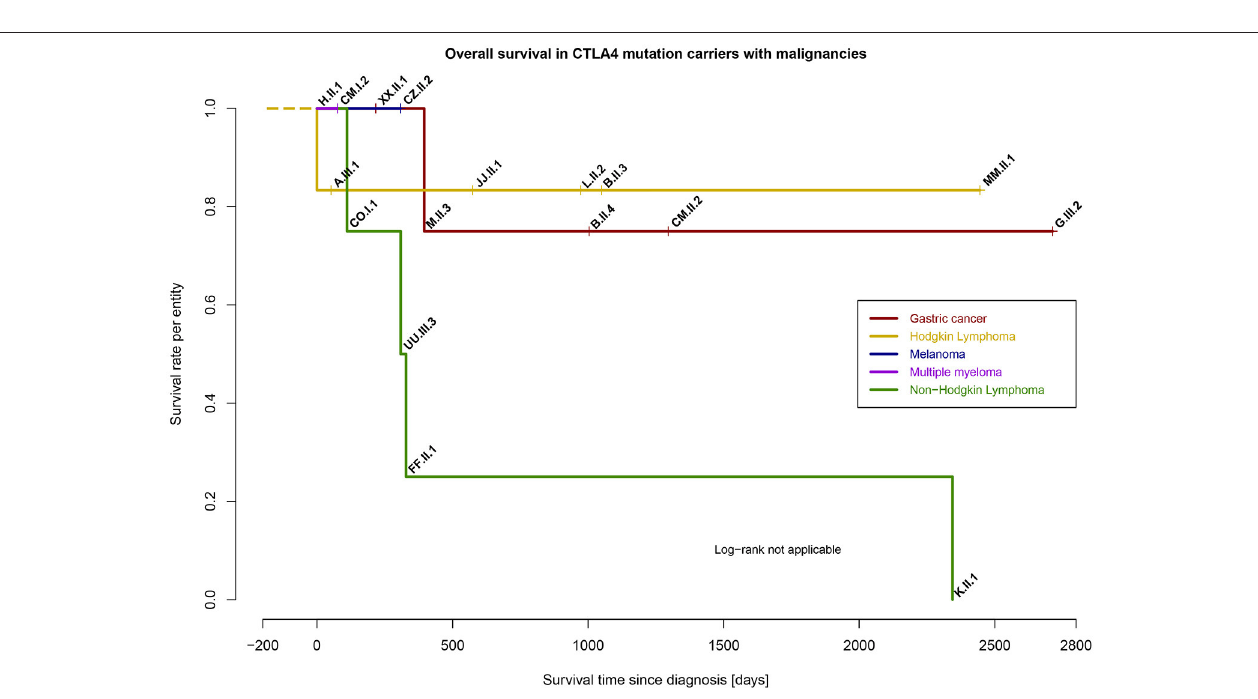
FIGURE 6 | Survival rate per entity of malignancies in CTLA4 mutation carriers ( n = 17), time range from day of diagnosis to last follow-up (days).